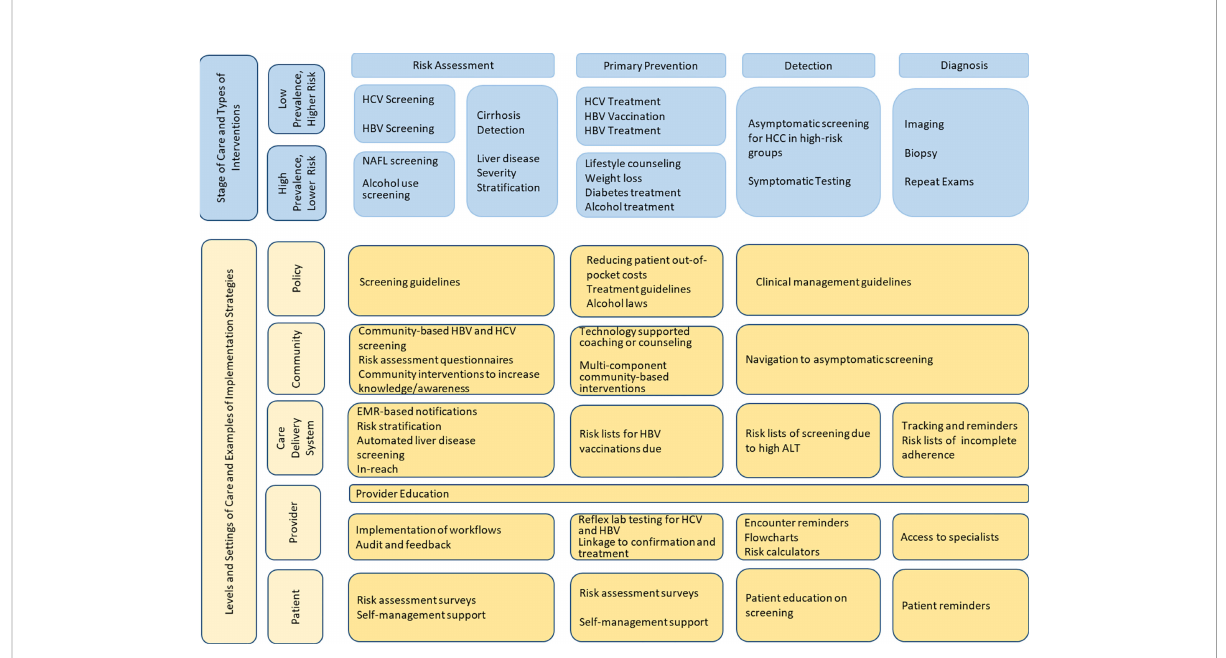
FIGURE 4 TeCH Framework: A conceptual model for improving primary and secondary prevention of HCC by focusing on implementation and evaluation of intervention strategies across the HCC care